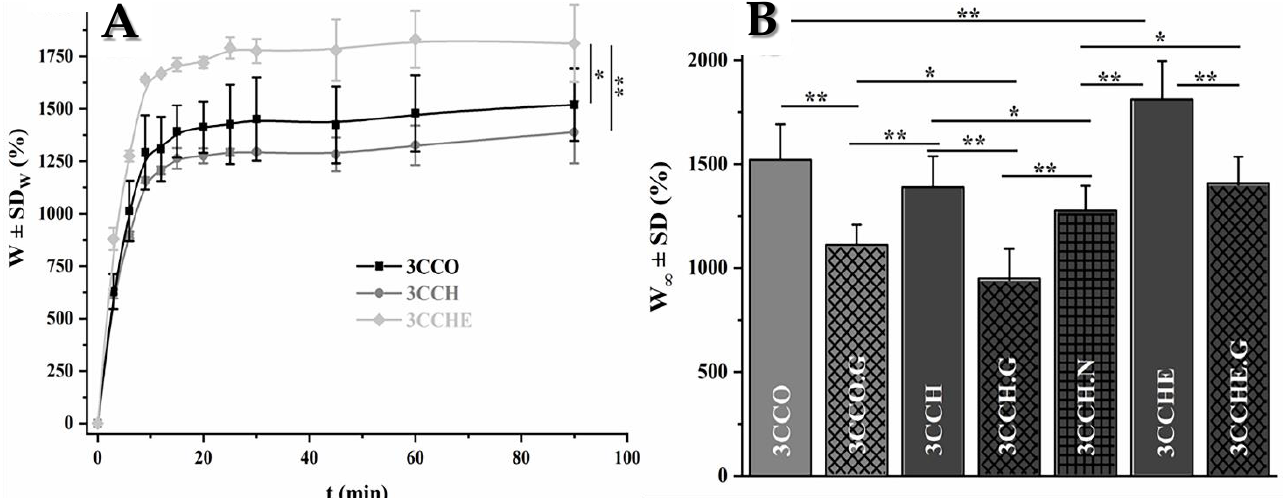
Figure 3. ( A ) Swelling profiles of the non-crosslinking samples and ( B ) maximum swelling after immersion for 90 min of all the scaffolds. Light gray indicates the use of OCP as the Ca-P material, and dark gray, the use of HAP. Non-filled bars denote non-crosslinking samples, while diagonal crosses denote the use of glutaraldehyde; straight crosses denote the use of the EDC/NHS crosslinking system.